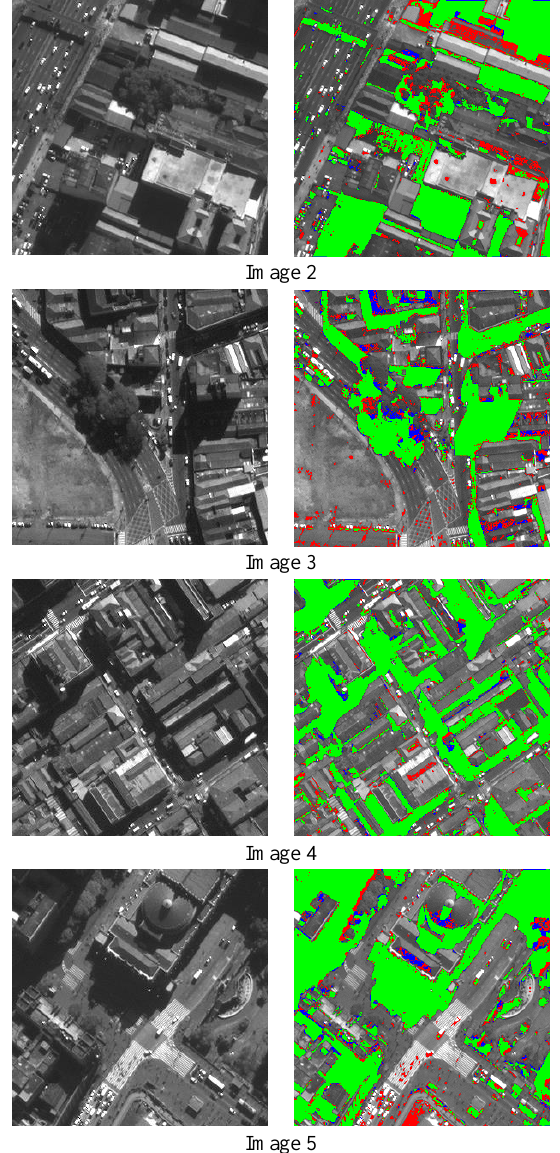
Figure 4. Comparison results for Image 2, 3, 4 and 5, respectively. (a) Original image; (b) Compared output